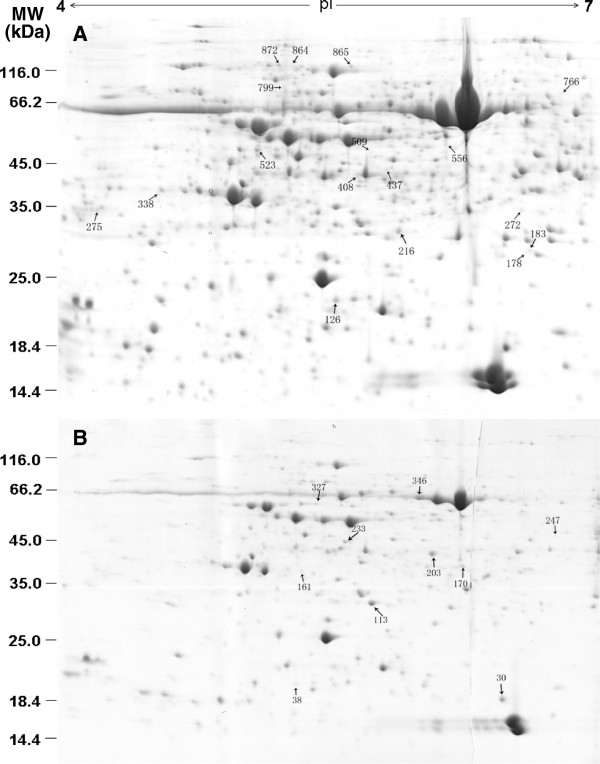
2-DE gel analysis of proteins extracted from the jin1-9/myc2 mutant. Separation on the first dimension was performed using 1300 μg of total soluble proteins using the linear gradient IPG strips with pH 4–7. In the second dimension, 12.5% SDS-PAGE gels were used, and proteins were visualized using coomassie brilliant blue. Arrows indicate 27 protein spots that changed reproducibly and significantly in MeJA-treated jin1-9/myc2 mutant plants compared to MeJA-treated wild-type plants. A and B represent 2-DE gels from jin1-9/myc2 samples treated with 200 mM MeJA for 6 h and 48 h, respectively. 2-DE experiments were repeated 3 times with independent biological replicates.